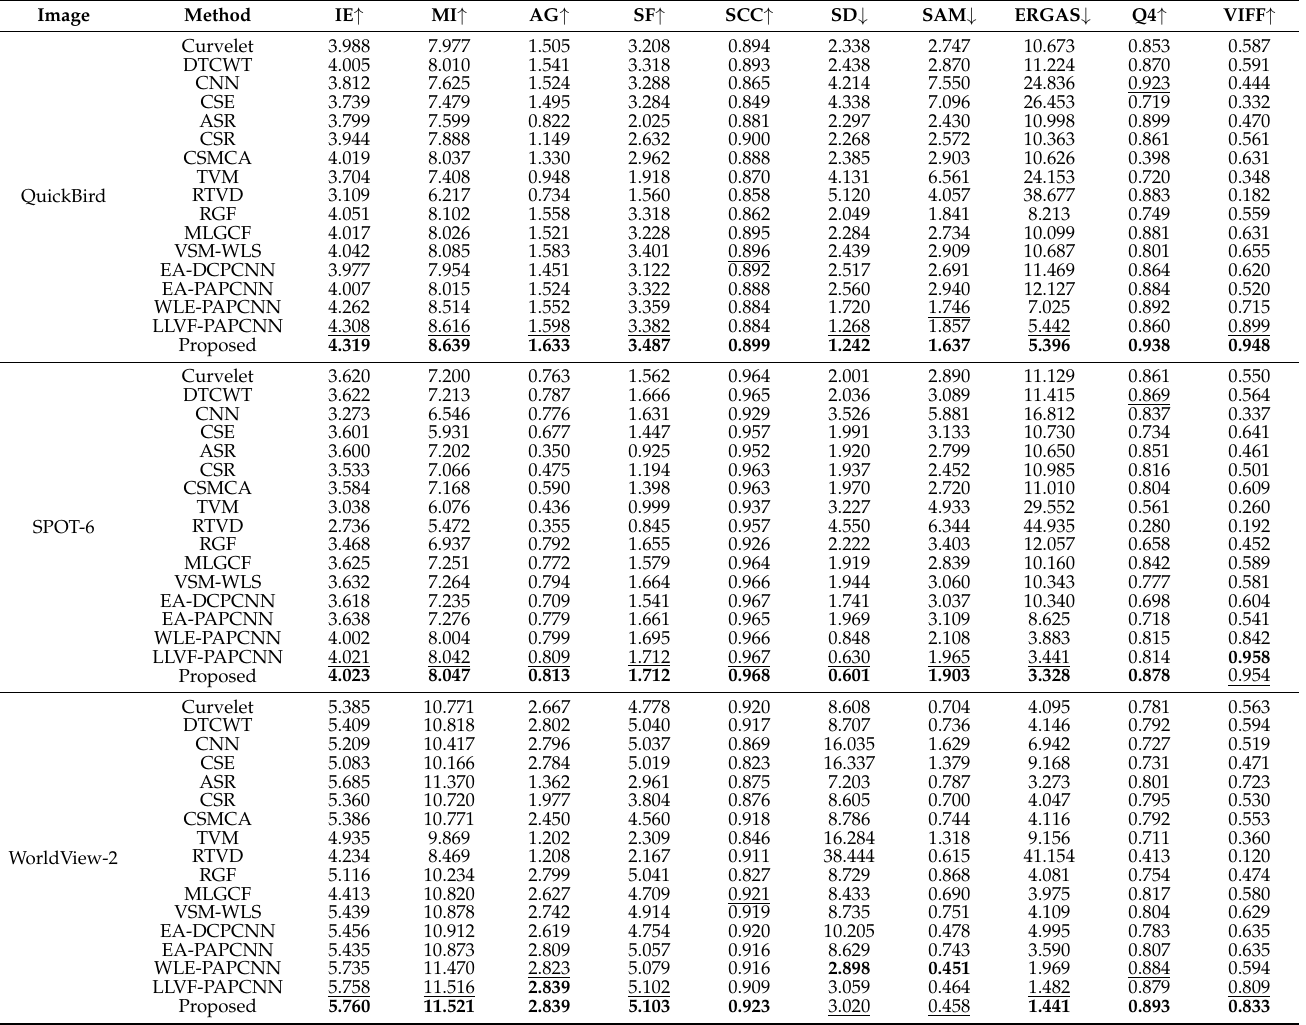
Table 1. Objective evaluation of 5 sets of image